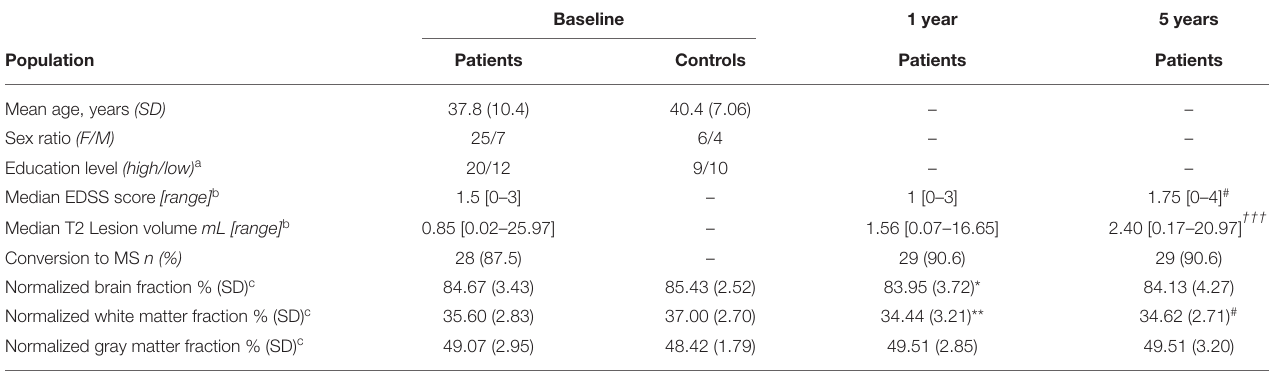
TABLE 1 | Patients demographic, clinical and conventional MRI